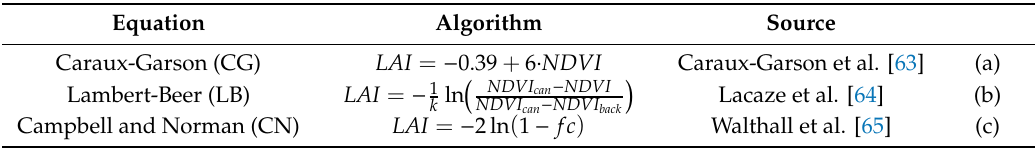
Table 2. Equations used to derive Leaf Area Index (LAI) from Normalized Di ff erence Vegetation Index (NDVI).